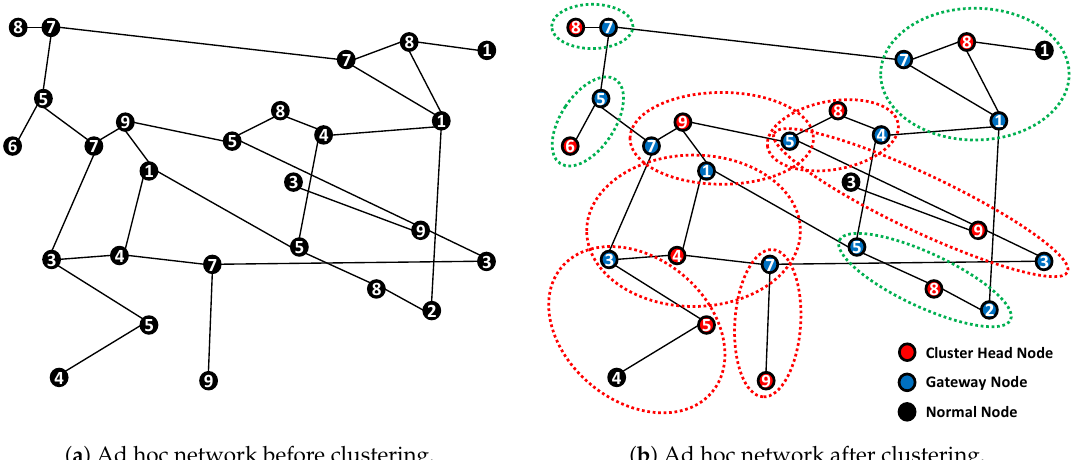
Figure 3. Examples of wireless ad hoc network